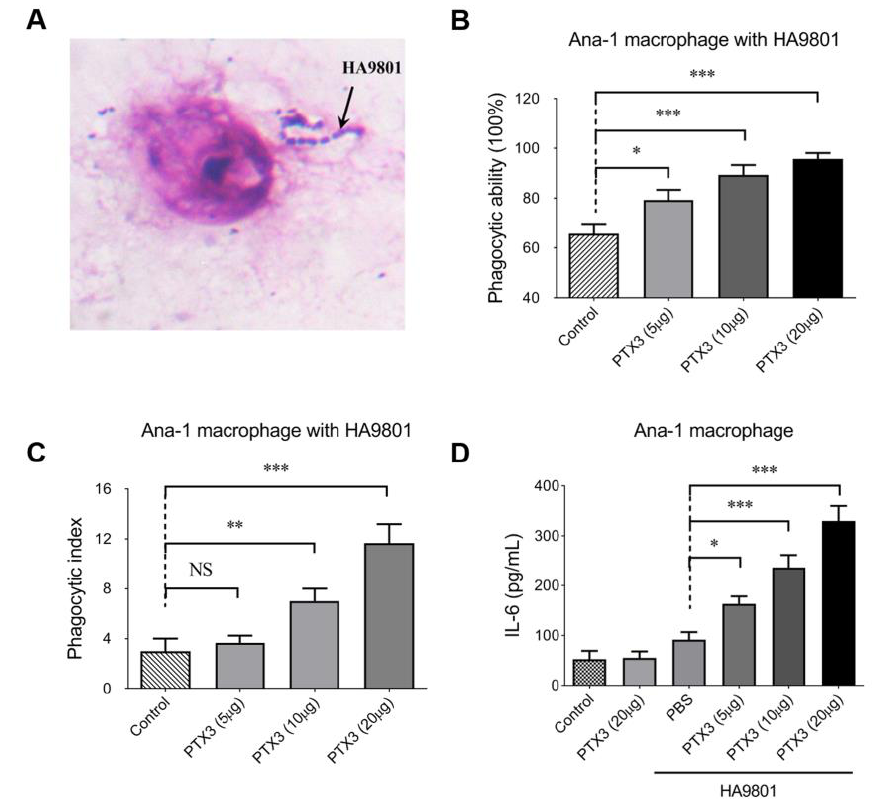
Figure 3. PTX3 enhanced the phagocytosis of mouse macrophage Ana-1 in strain HA9801. ( A ) The observation of Ana-1 swallowing HA9801 stained with Giemsa by microscope (10 × 100). The phagocytic ability ( B ) and phagocytic index ( C ) of macrophage Ana-1 to SS2 strain HA9801 were assessed under the treatment of different doses of PTX3 protein (5, 10, 20 µ g). Phagocytic ability was defined as the percentage of Ana-1 cells that trapped bacterial cells of strain HA9801; phagocytic index was defined as the average quantity of bacterial cells swallowed by each Ana-1. ( D ) The levels of the cytokine IL-6 were detected under the treatment of PTX3 protein (5, 10 and 20 µ g) during the HA9801 infection. Data were shown as the mean ± SEM of three independent experiments performed in triplicate. Statistical significance was determined by a Student’s t -test based on comparisons with the PBS group (ns, p > 0.05; * p < 0.05; ** p < 0.01; *** p < 0.001).